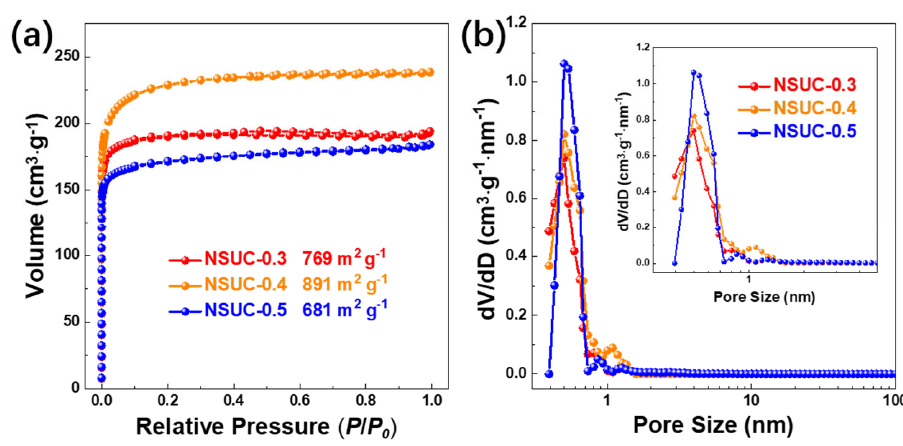
Table 1. Pore structure parameters and chemical compositions of NSUC- x .